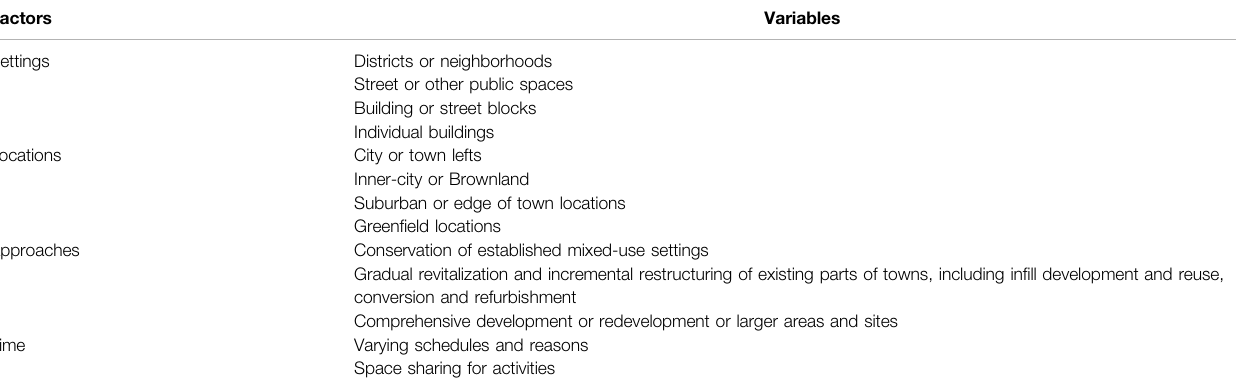
TABLE 1 | Factors and variables for the application of mixed-use